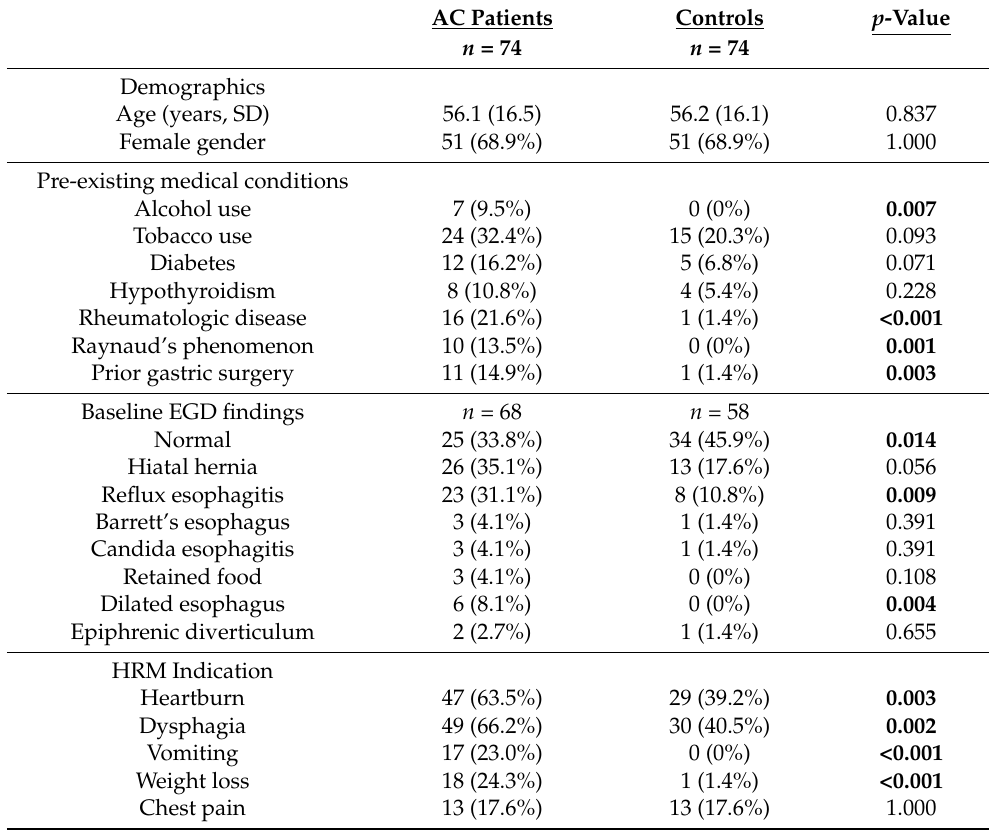
Figure 2. Typical high-resolution manometry findings in a patient with absent contractility. This figure shows three swallows from a 20-year-old man. No contractility is noted in the esophageal body during any of the swallows, while the lower esophageal sphincter relaxes appropriately each time. Table 1. Baseline characteristics of absent contractility patients versus